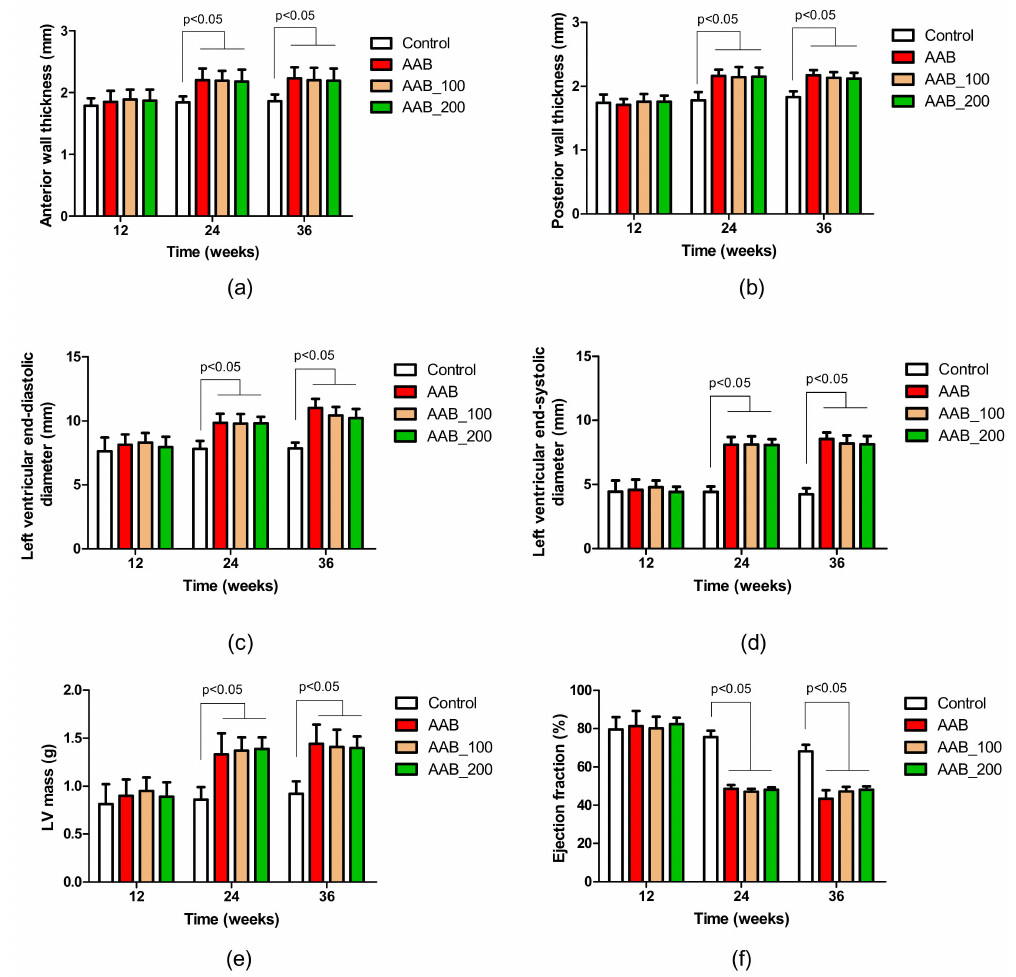
Figure 2. Evolution of echocardiographic parameters. ( a ) Anterior wall thickness (AWT); ( b ) Posterior wall thickness (PWT); ( c ) Left ventricular end-diastolic diameter (LVEDD); ( d ) Left ventricular end-systolic diameter (LVESD); ( e ) Left ventricular (LV) mass; ( f ) Ejection